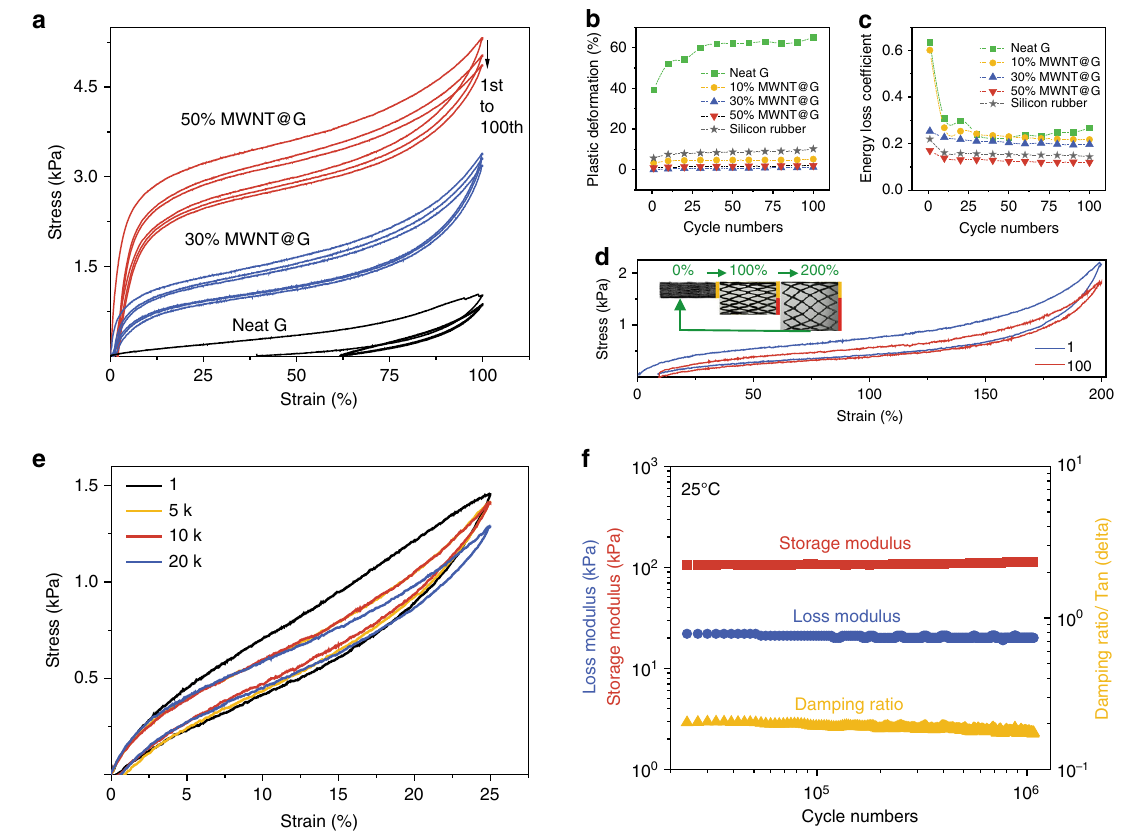
Fig. 4 Fatigue resistance tests. a Stress-strain curves of bCAs with increasing dose of MWNTs at 100% tensile strain for 100 cycles (density: 9.7 mg cm − 3 ). b , c Plastic deformation and energy loss coef fi cient ( γ ) during the fi rst 100 tensile cycles in a . d Cyclical tensile-release curves for a designed bCA with stretchable ratio of 200%. e Cyclical stretching curves for 20 000 times at 25% stain at the rate of 0.01 s − 1 . f Fatigue resistance of bCA during 10 6 stretching cycles at 1% strain by DMA at 100